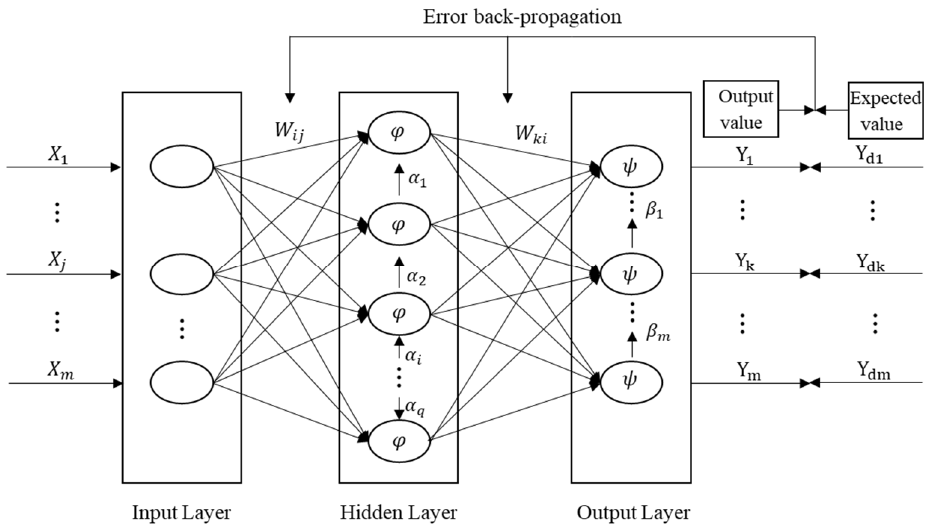
Figure 1. Three-layer BP neural network structure.